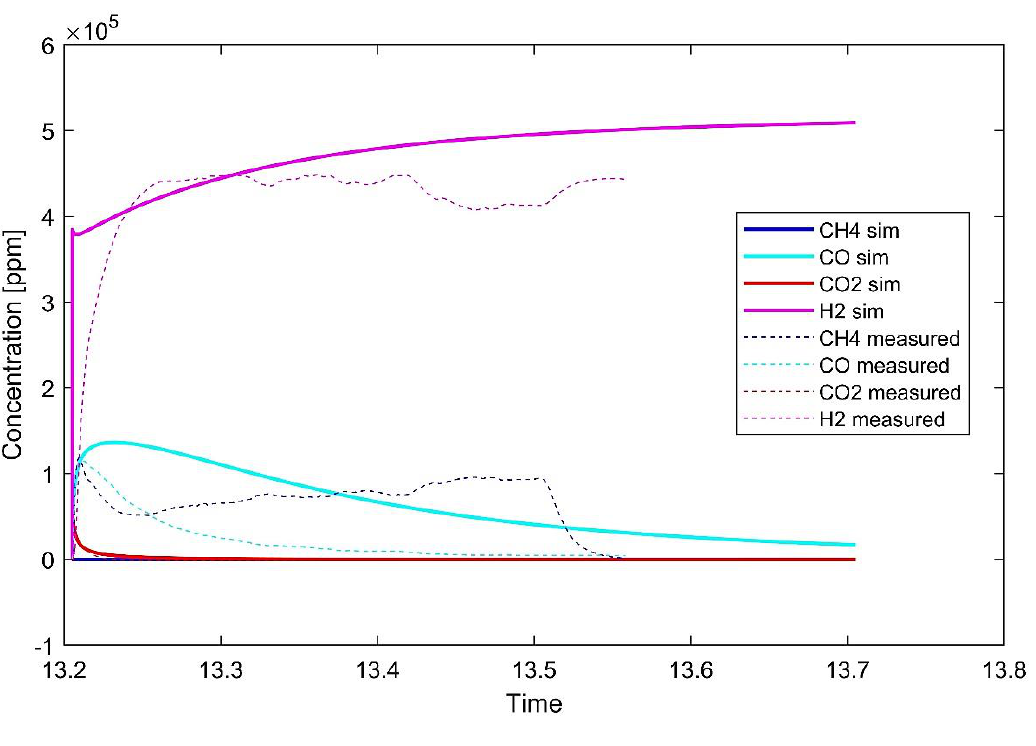
Figure 4. Comparison of experimental results (test #3) and simulation.